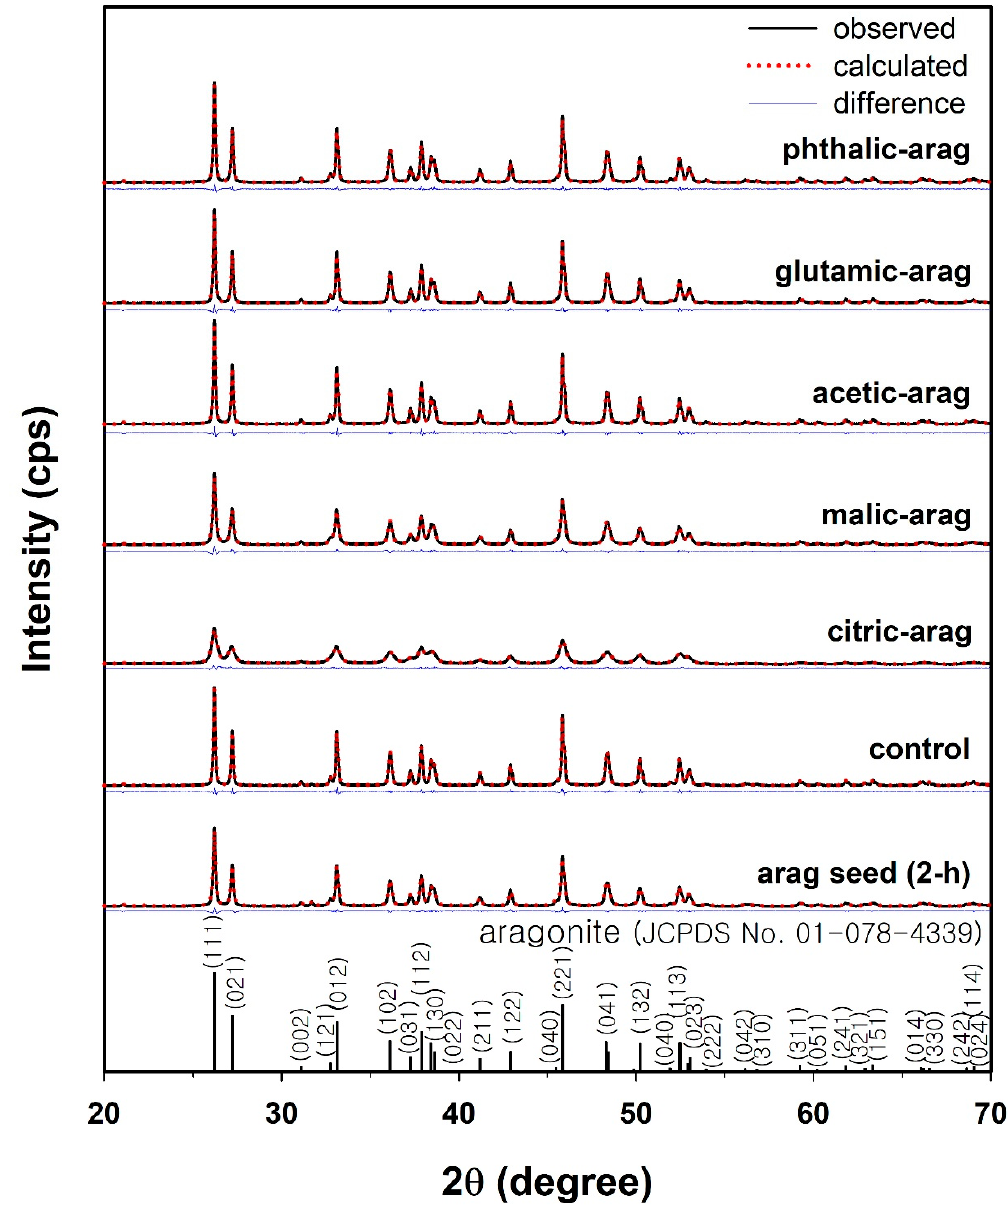
Figure 4. XRD patterns for the used aragonite seed (2-h) and the organic co-precipitated aragonite samples.